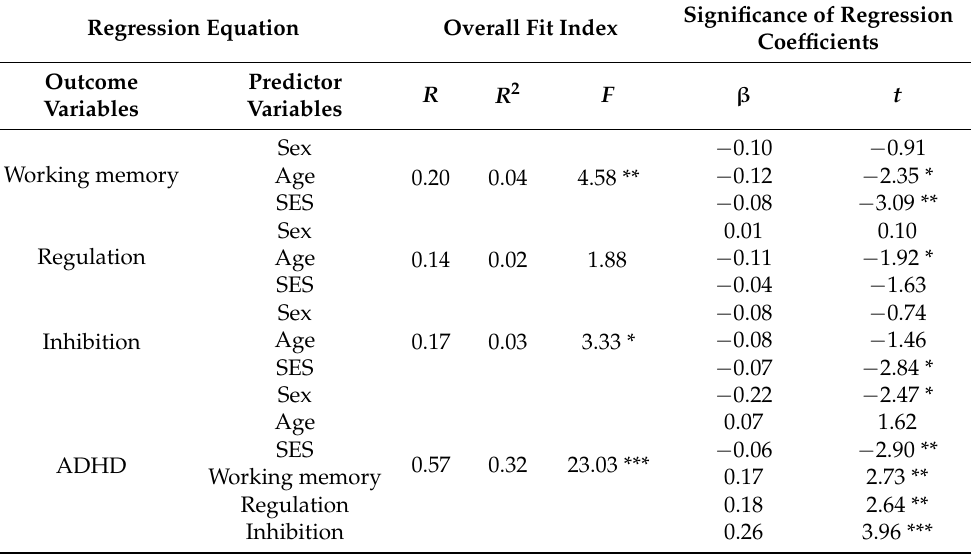
Table 4. The regression analysis of the SES and EF dimensions on ADHD in preschool children. Regression Equation